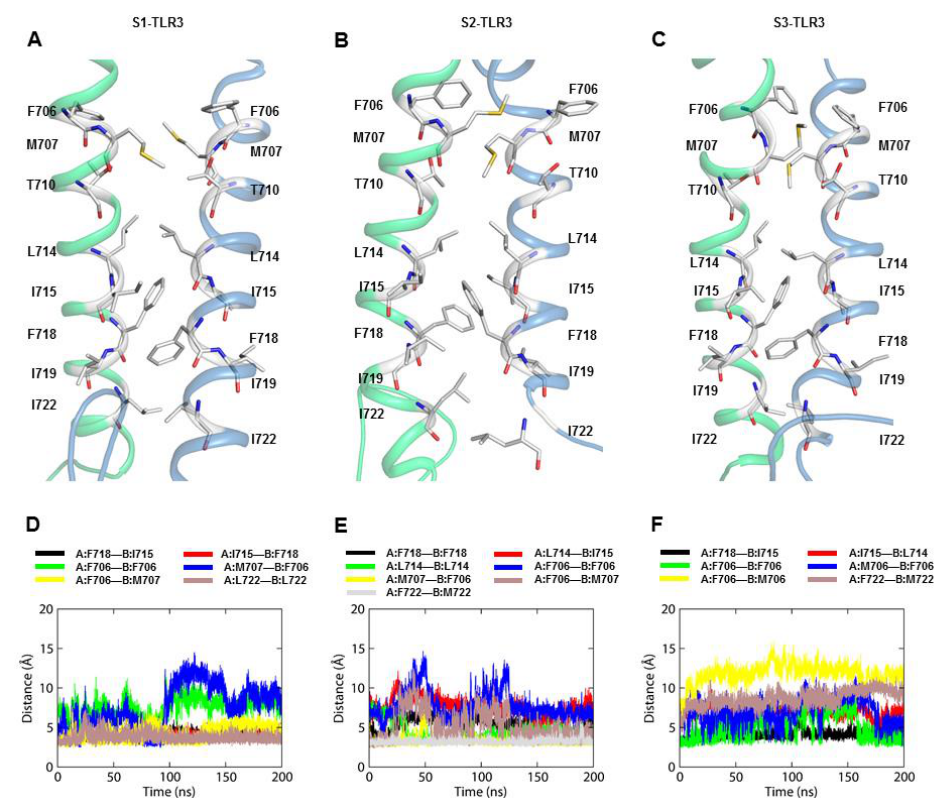
Figure 7. Dimer packing interaction of TM domains. ( A – C ) Comparison of the dimer packing interaction at the helix-helix interfaces of the S1-, S2-, and S3-TM dimers from representative low-energy conformations. Residues previously reported to play an important role in TM dimerization are highlighted as stick models. Subunit A and subunit B of the TM dimer are colored blue and green, respectively. ( D – F ) Time-dependent distances between the amino acid side-chains that were involved in the helix-helix interaction along the molecular dynamics trajectory. S1, S2, and S3 represent replicate 2 of sets 1, 2, and 3, respectively. Table 3. Distance between the center of mass of important TM domain residues in three representative simulations.